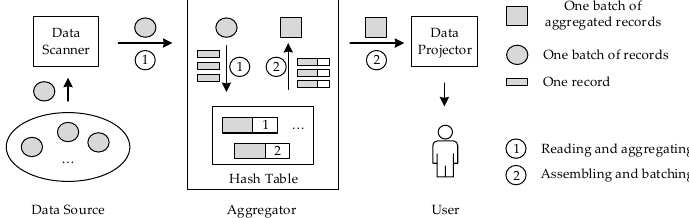
Figure 1. An typical implementation of the group operator of vectorized databases.